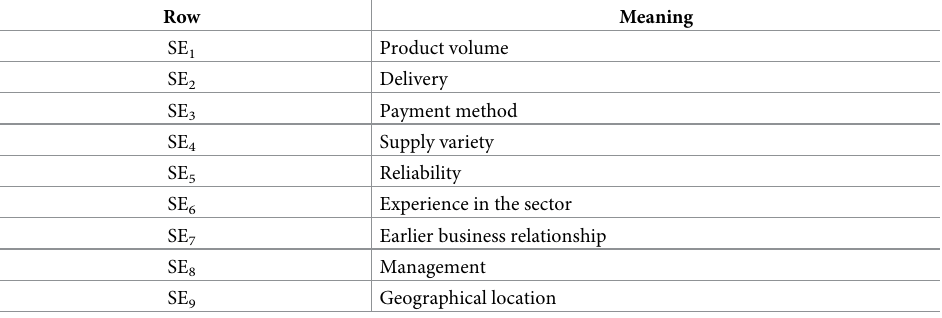
Table 5. Determined SEs for the medical products.